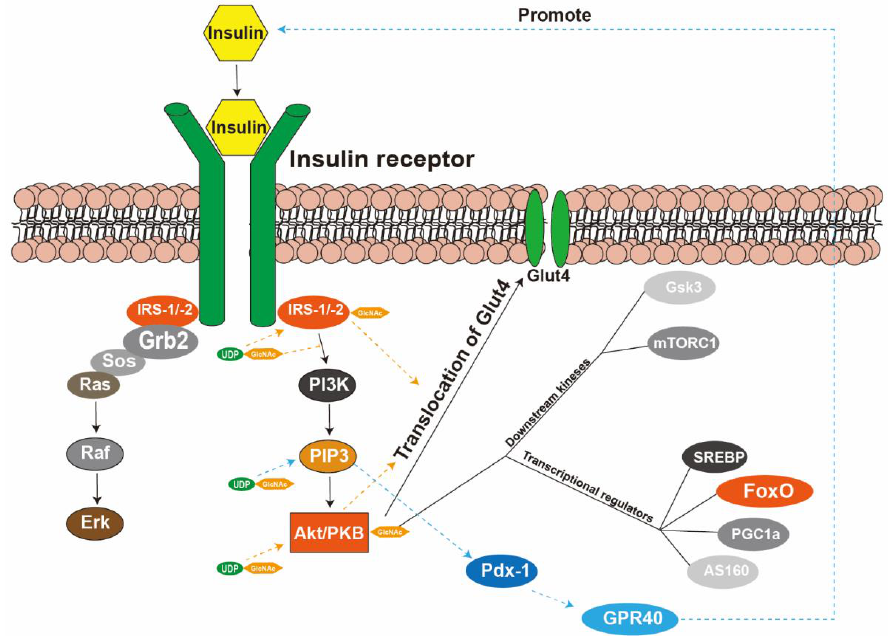
Figure 2. Schematic representation of the O -GlcNAcylation pathway contributing to type 2 diabetes. In islet cells, high glucose and insulin contribute to OGT overexpression, which leads to insulin resistance by reducing the phosphorylation of insulin receptor substrate (IRS), protein kinase B (Akt), and the interaction between IRS and phosphoinositide 3-kinase (PI3K). Abbreviations: IRS, insulin receptor substrate; Grb2, growth factor receptor-bound protein 2; Sos, salt overly sensitive; Erk, extracellular regulated protein kinases; UDP-GlcNAc, UDP-N-acetylglucosamine; PI3K, phosphoinositide 3-kinase; PIP3, phosphatidylinositol (3,4,5)-triphosphate; Glut4, glucose transporter-4; Gsk3, glycogen synthase kinase 3; mTORC1, mechanistic target of rapamycin complex 1; SREBP, sterol regulatory element-binding protein; FoxO, Forkhead box O; PGC1a, peroxisome proliferator-activated receptor- γ coact ivator 1- α; AS160, Akt substrate of 160 kDa; Pdx -1, pancreas-duodenum homeobox-1; GPR40, G protein-coupled receptor 40.